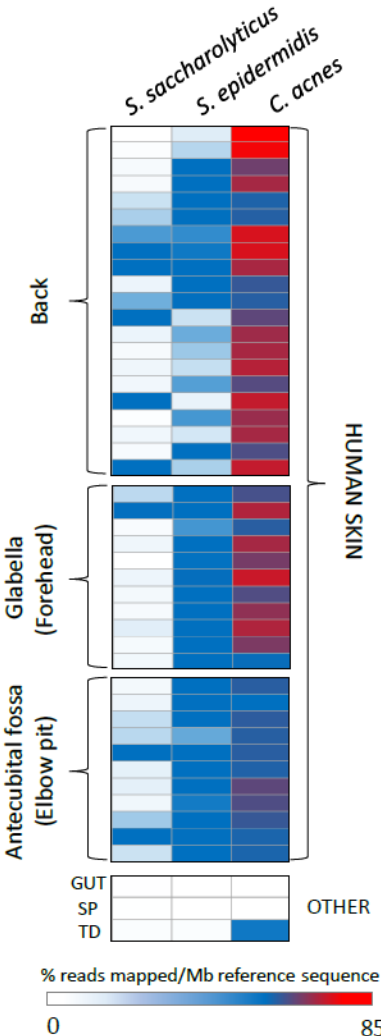
Figure 2. Representation of S. saccharolyticus in human skin and human-associated metagenomes. Heat map showing relative representation of S. saccharolyticus in metagenomes from human skin and other human associated environments. Reads from each reference metagenome were mapped to the genome sequences of S. saccharolyticus, S. epidermidis, and Cutibacterium acnes using high stringency criteria (100% identity; no gaps; max. ambiguity 1). The number of reads mapped was normalized for size of reference datasets (expressed as % of reads mapped/Mb reference sequence). OTHER: non-human skin metagenomes; GUT: human gut; SP: supragingival plaque; TD: tongue dorsum. Details of the metagenomes utilized are provided in Table S3.